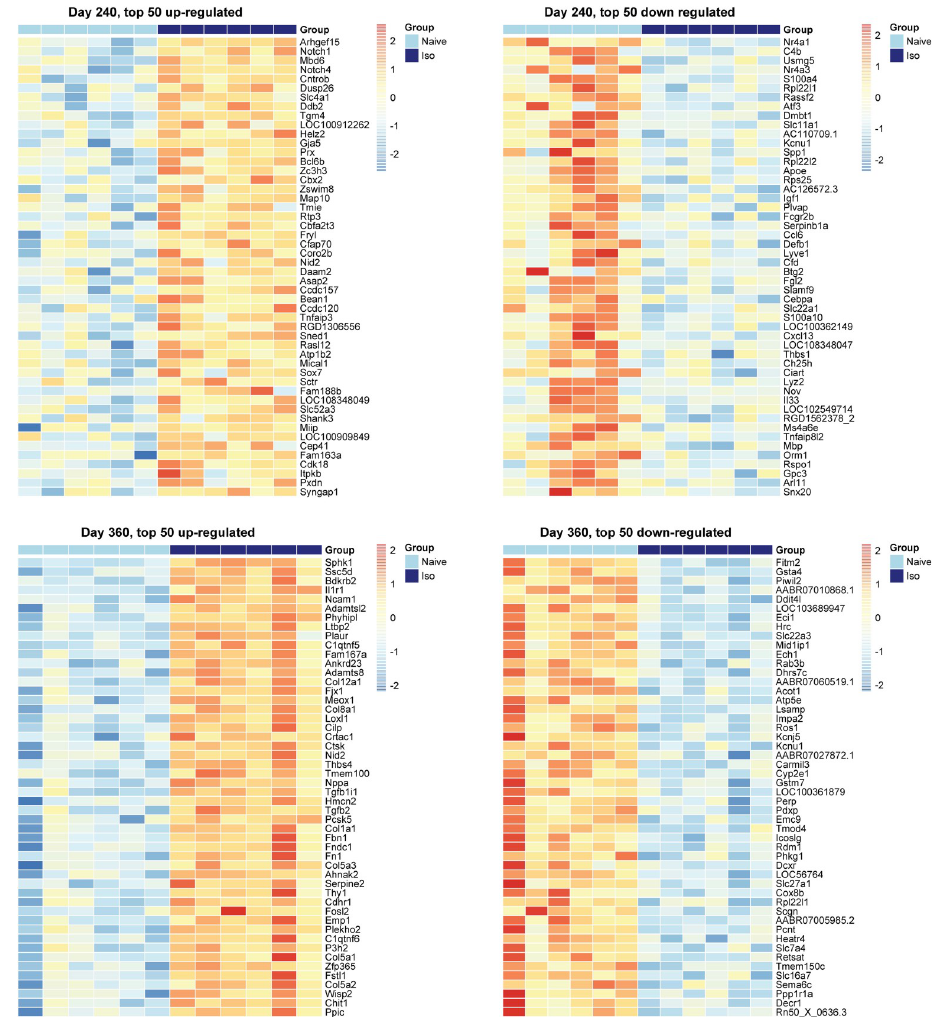
Fig 4. Heatmaps of top 50 up-regulated and down-regulated DEG at Days 240, and 360. In the group scale, the light blue stands for na ï ve samples and dark blue represents ISO samples. For each gene, expression values were standardized by the mean and standard deviation across samples. In the color scale, the red color means the expression value is above the average, while blue color means the expression value is below the average. Groups of rats exposed to air (na ï ve, n = 6/Day 240 and 360 groups) or ISO (n = 6/Day 240 and 360 groups) were used.